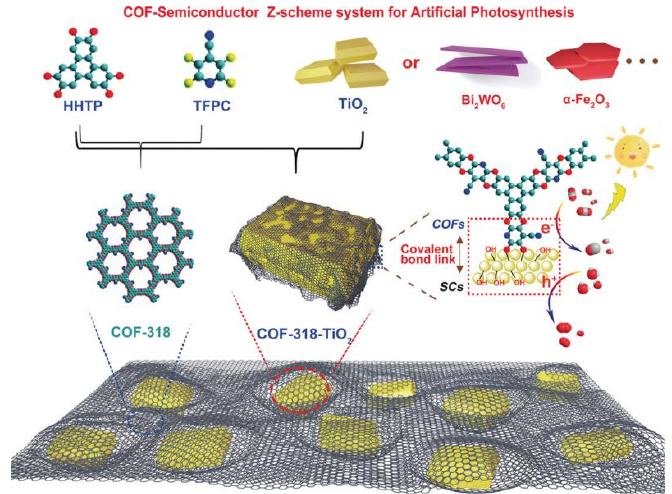
Figure 11. Schematic representation of the preparation of COF-318-SCs via the condensation of COF-318 and semiconductor materials. Copied with permission from Wiley 2020 [41].